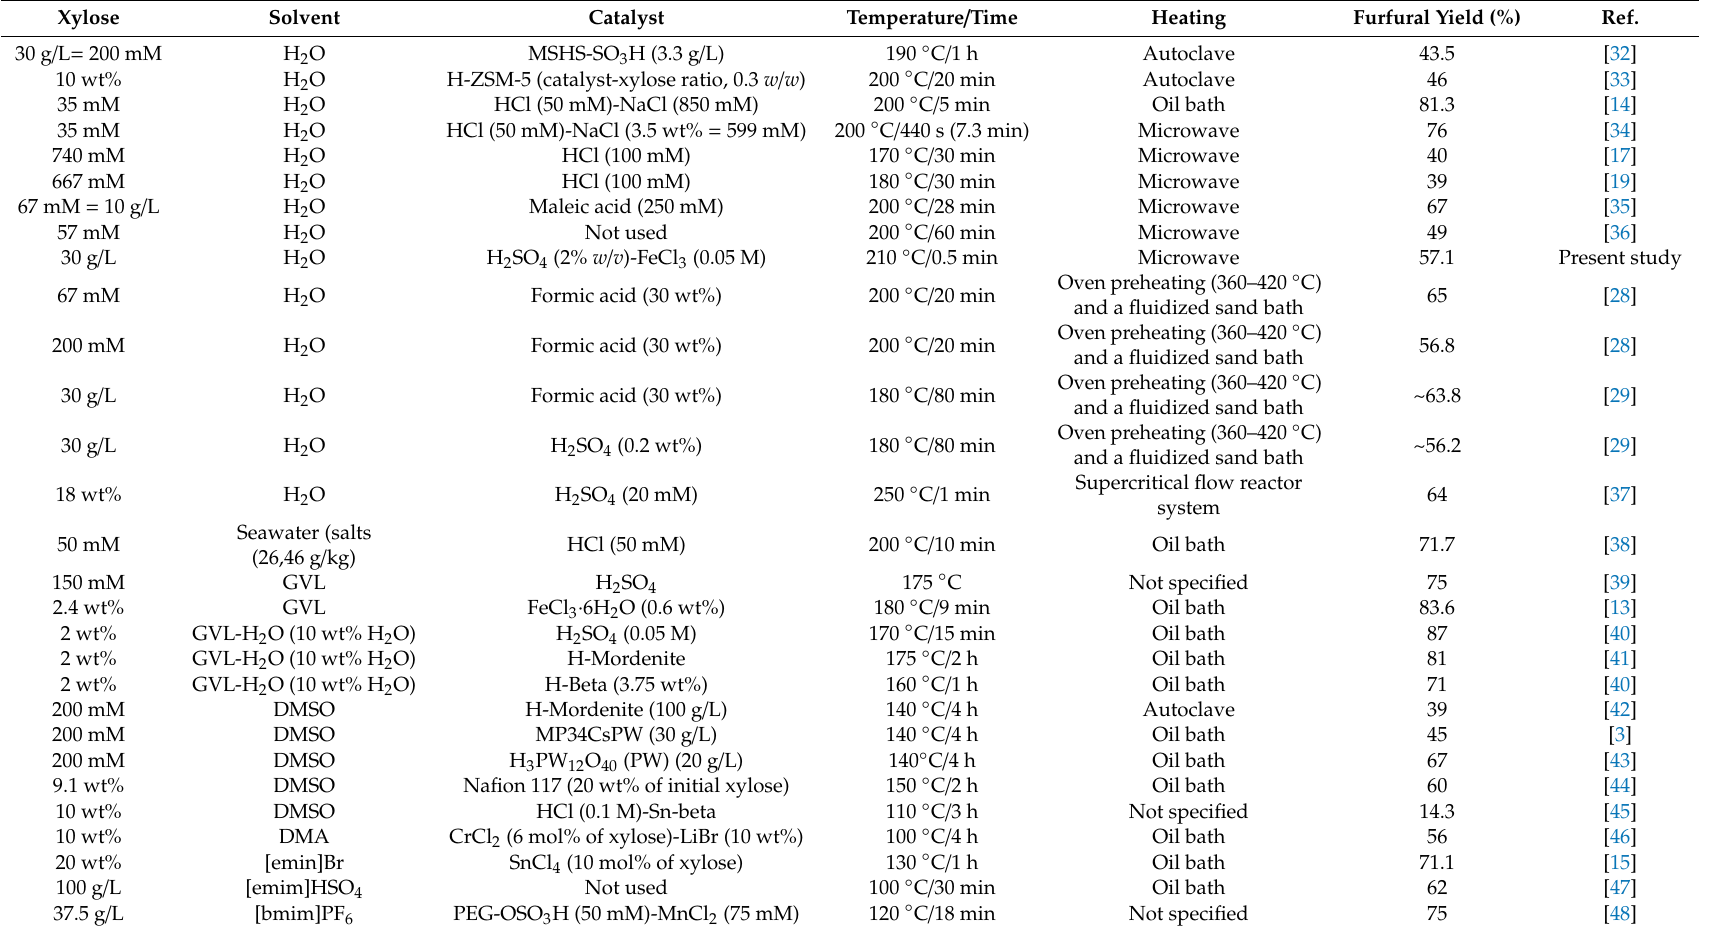
Table 6. Yield results of furfural production from xylose in green solvents in the monophase system. Xylose Solvent Catalyst Temperature / Time Heating Furfural Yield (%)